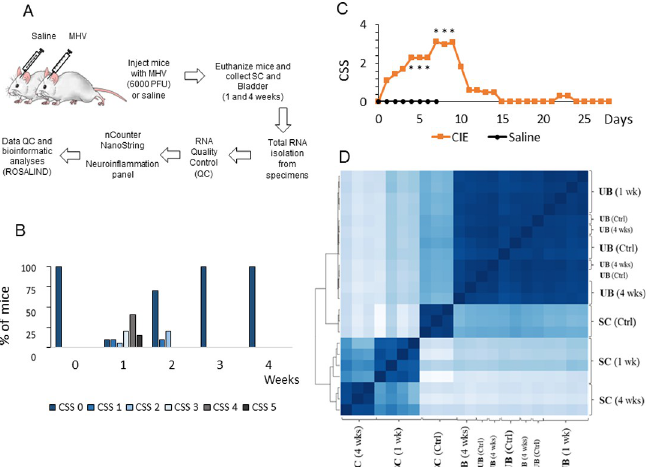
Fig 1. Experimental design of the study and clinical symptom scoring of the disease progression. A, Schematic presentation of experimental groups, time points and RNA analysis approach. B, Percentage of mice developed different levels of neurodegeneration, as evaluated by the clinical symptom scores (CSS) during experimental timeline. C, Average daily CSS values for CIE mice. D, Heat map of the genes expressed in the SC and UB samples isolated from control and CIE mice at 1 and 4 wks